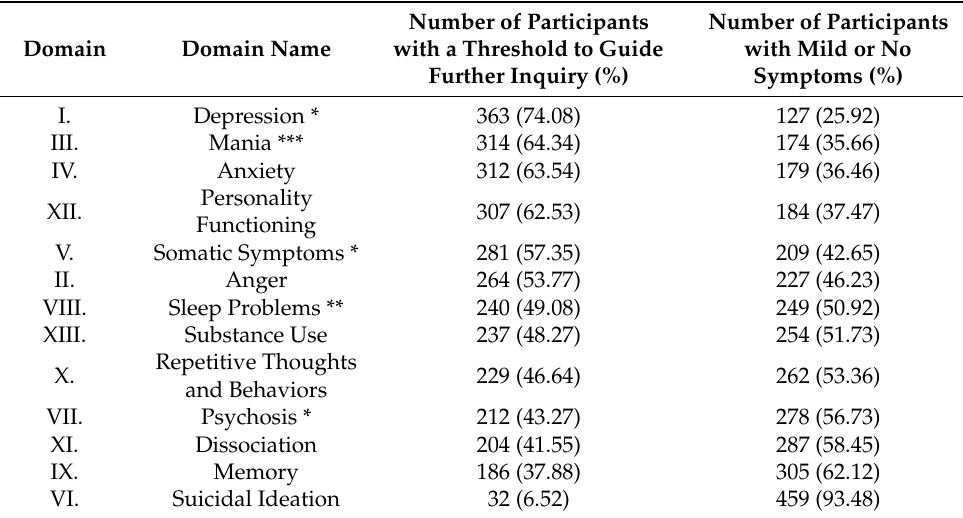
Table 3. Number of participating emerging adults (aged 18–30 years) who would warrant further inquiry based on DSM-V domain criteria, Saudi Arabia,